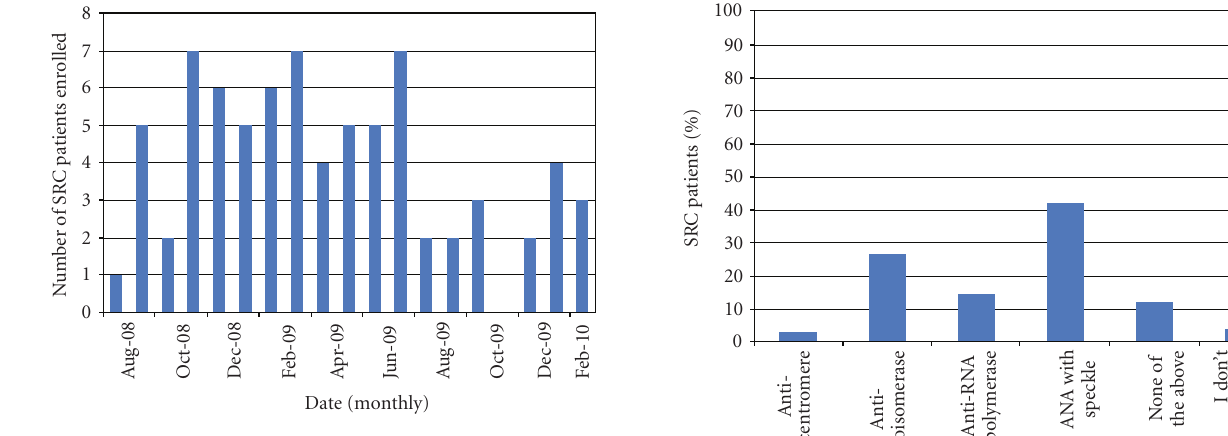
Figure 1: Rate of recruitment of study subjects.